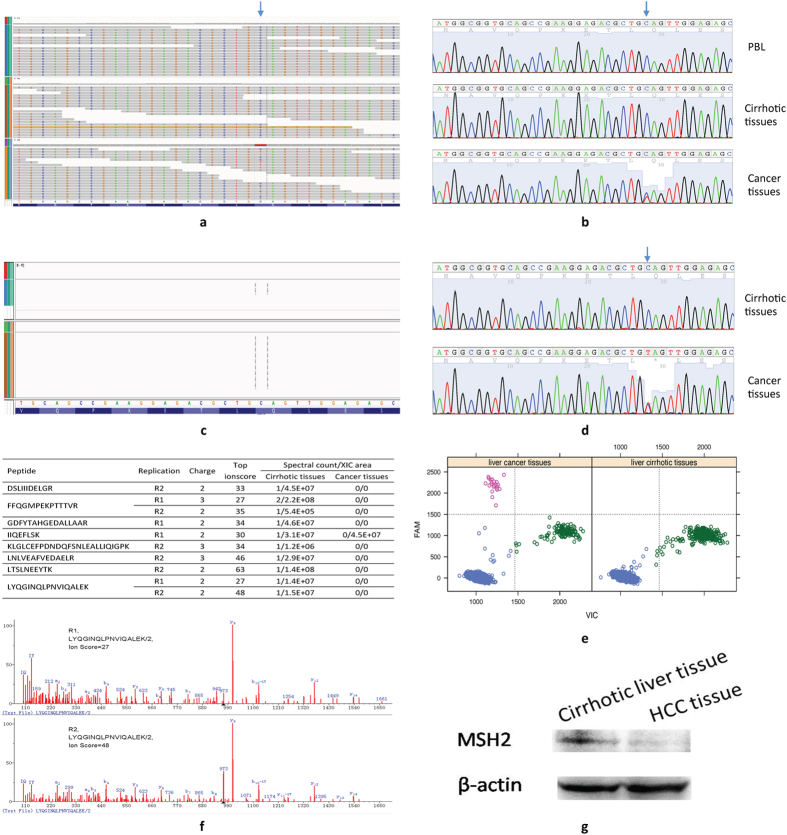
A novel nonsense mutation in MSH2.(a) WES identified a nonsense mutation, which was confirmed by Sanger sequencing (b). The nonsense mutation was not identified by RNA-Seq (c), but was confirmed by Sanger sequencing (d) and droplet digital PCR (e). The arrow indicates the nonsense mutation. (f) Mass spectrometry (MS) identified MSH2 peptides in the liver cirrhotic tissue and not in the cancer tissue. The inserted table illustrated the MSH2 peptides identified in the cirrhotic tissue by two independent MS experiments. (g) Western plot showing a down-regulated expression of MSH2 in the liver cancer tissue, compared with the cirrhotic tissue. R1, replicate #1; R2, replicate #2; FAM: 5-carboxyfluorescein; and VIC: registered name. PBL, peripheral blood lymphocyte.